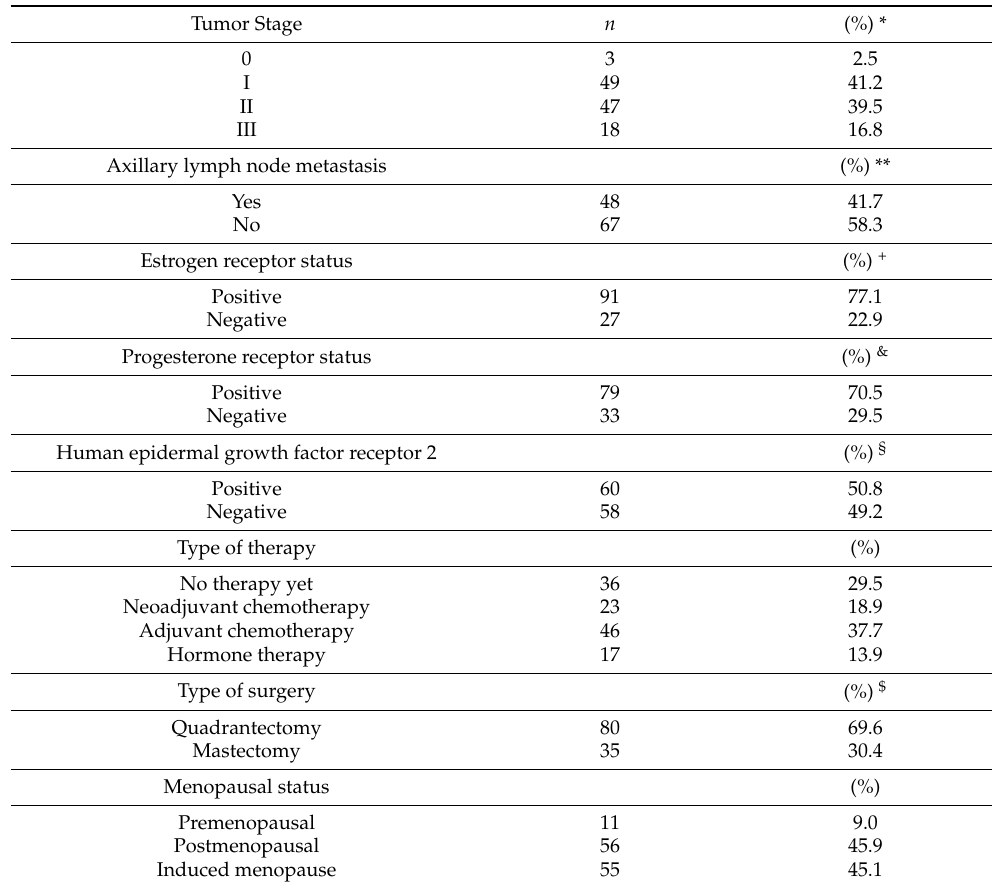
Table 2. Clinical characteristics of patients with